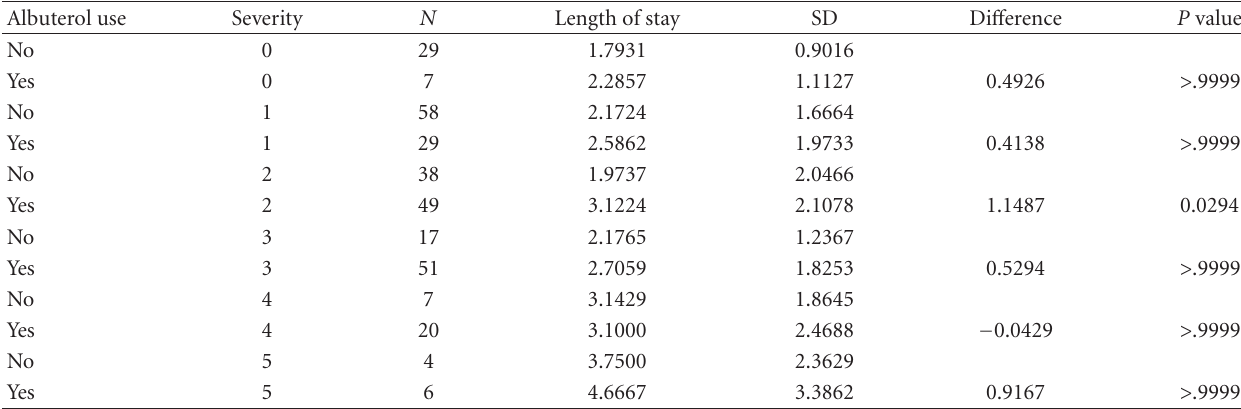
Table 3: Albuterol use, severity, and length of